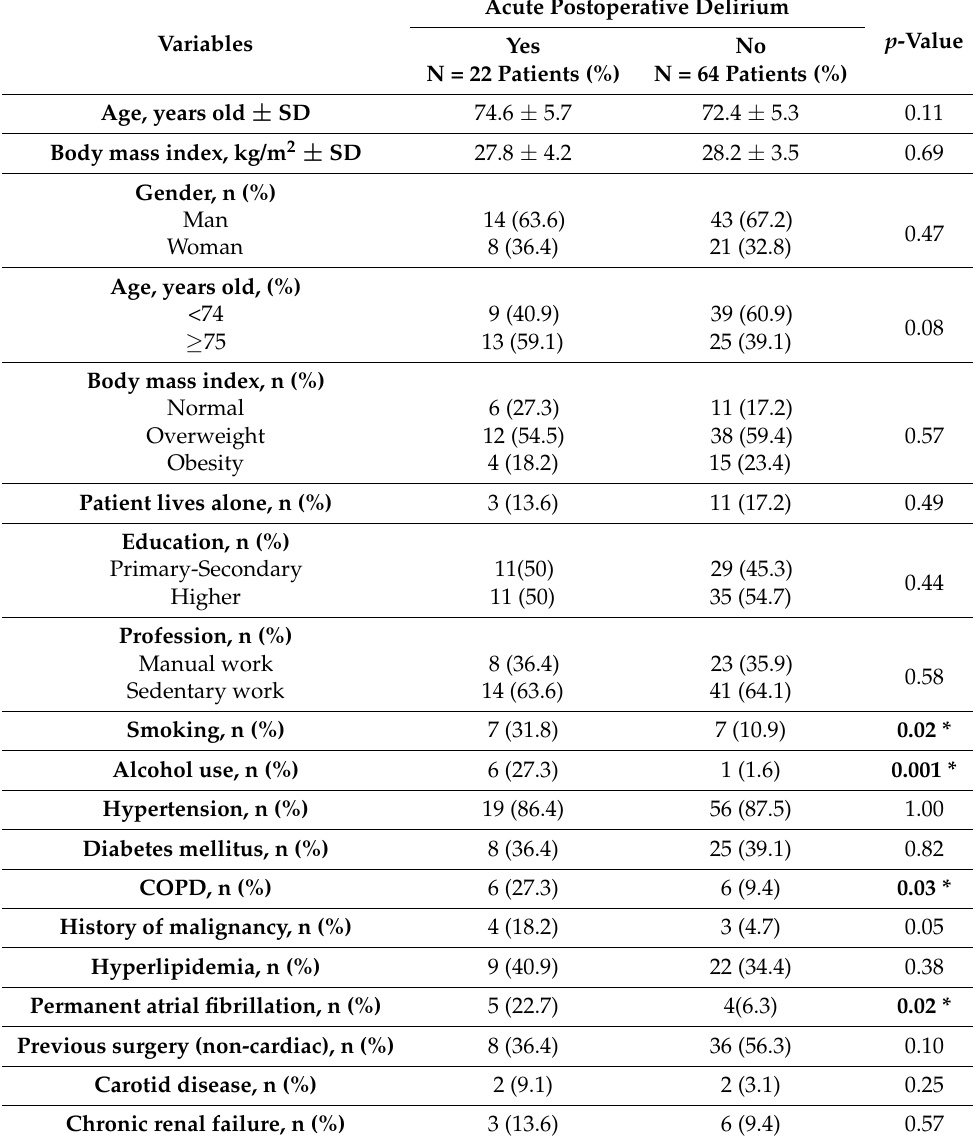
Table 3. Comparison of demographic characteristics between two groups with and without acute postoperative delirium. Chronic obstructive pulmonary disease = COPD; number = N or n; standard deviation = SD. * Statistical significance p <